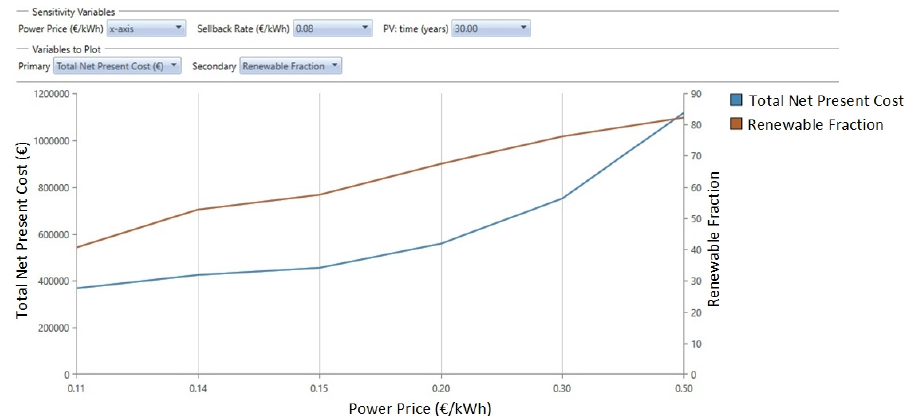
Figure 14. Sensitivity analysis in relation to price of energy from the grid.